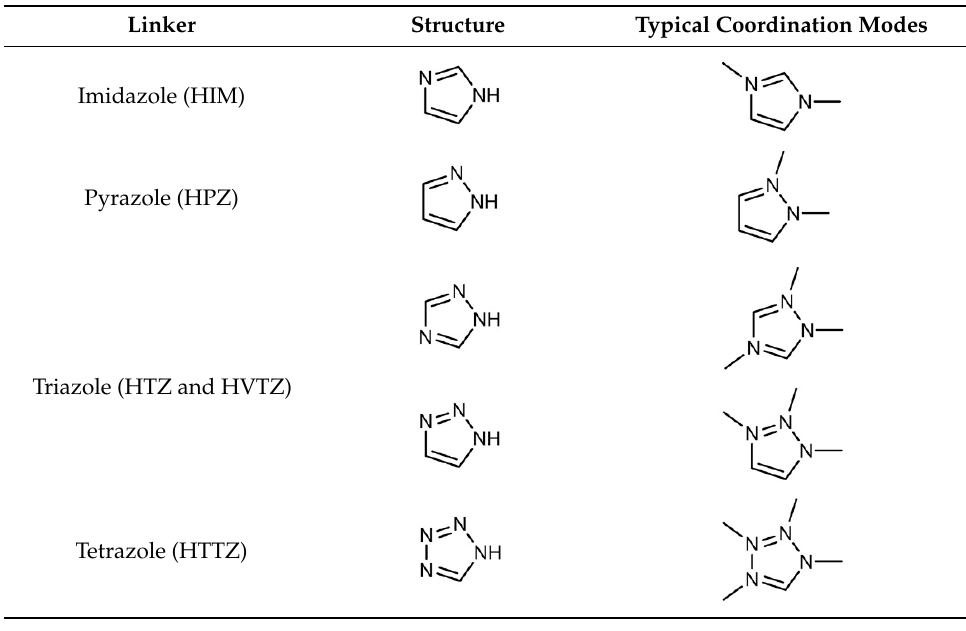
Table 2. Structure and typical coordination modes of azolates.